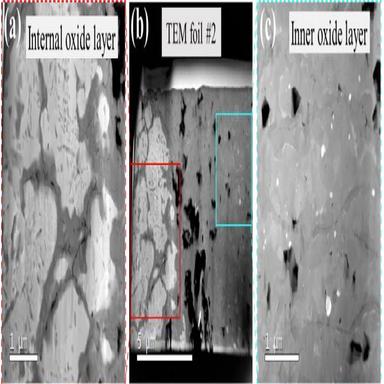
TEM HAADF images at the internal-inner oxide layer interface of T91 after exposure in SCW at 600 °C for 1500 h.